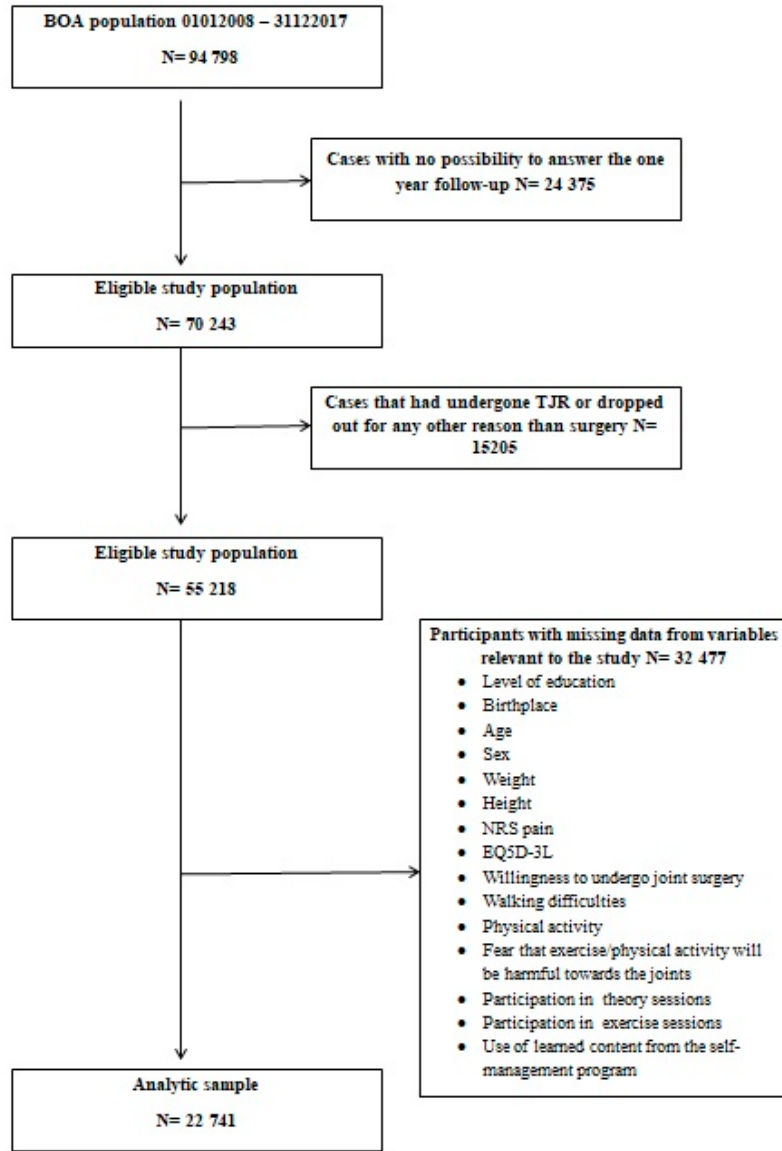
Figure 2. Inclusion and exclusion processes for defining the analytical sample of the study.